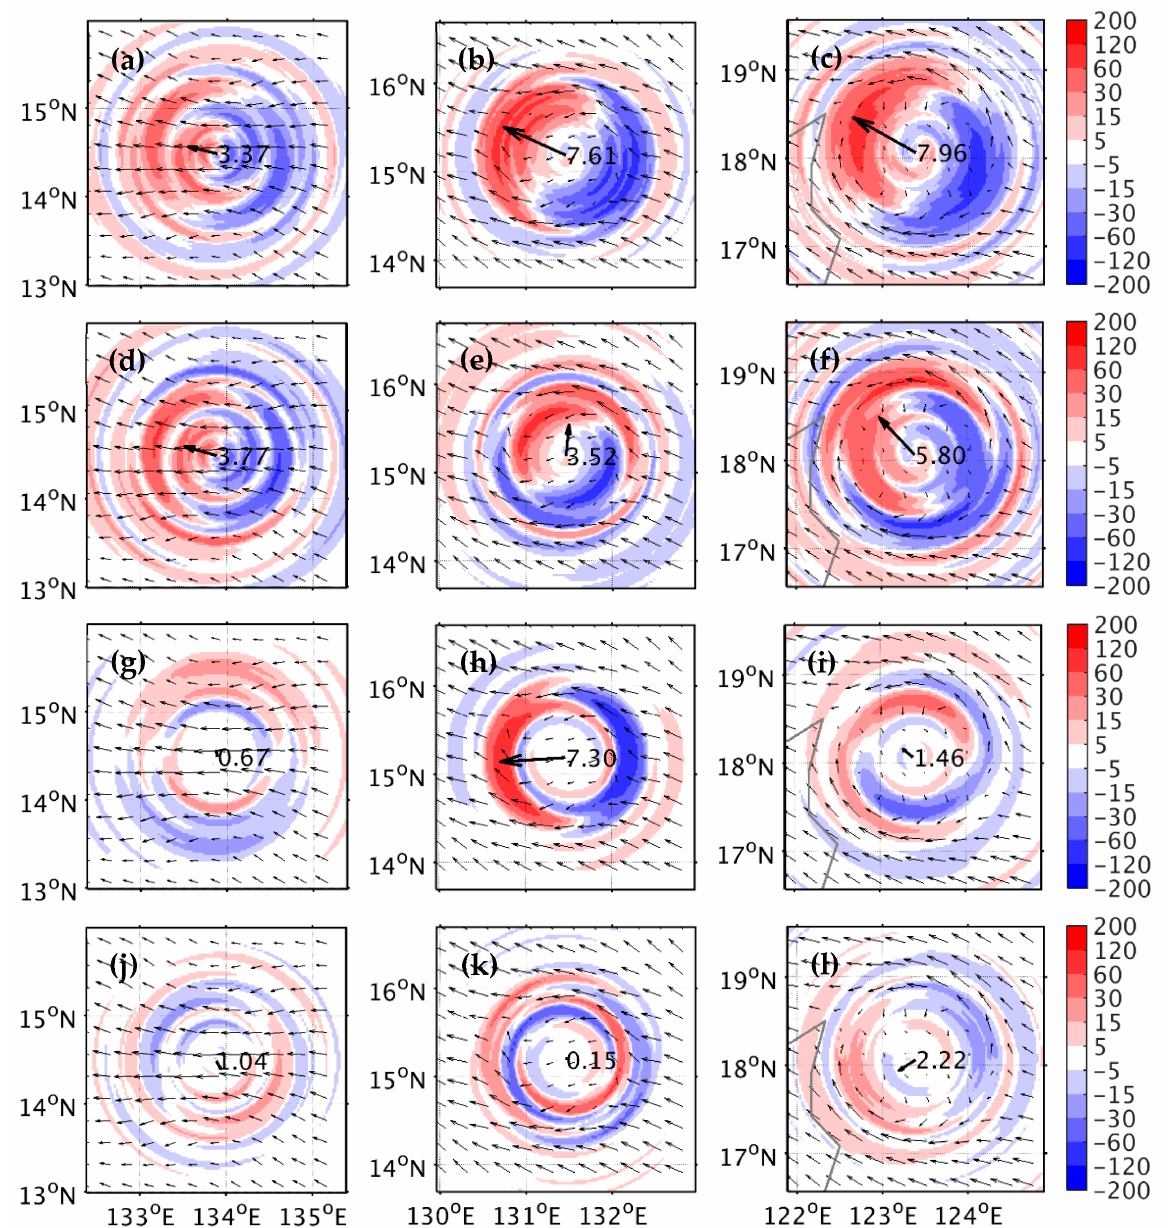
Figure 13. The WN-1 horizontal flow and PV tendency budget ( shaded colors, 10 − 5 PVU s − 1 ) averaged in 1–8 km height for MK-CTL at 48 h for ( a ) net PV budget, ( d ) horizontal PV advection, ( g ) vertical PV advection, and ( j ) differential diabatic heating. ( b ), ( e ), ( h ), and ( k ) are the same as in ( a ), ( d ), ( g ), and ( j ), respectively, but at 60 h. ( c ), ( f ), ( i ), and ( l ) are the same as in ( a ), ( d ), ( g ), and ( j ), respectively, but at 93 h. The bold reference wind vector (in m s − 1 ) indicates the induced vortex translation velocity. The budget results are averaged within 1 h ahead of the analysis time.